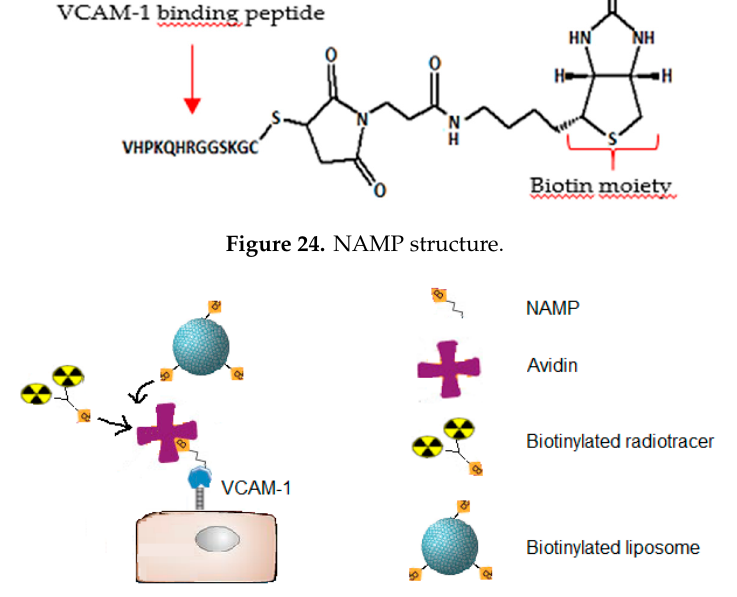
Figure 25. Three-step theragnostic system.